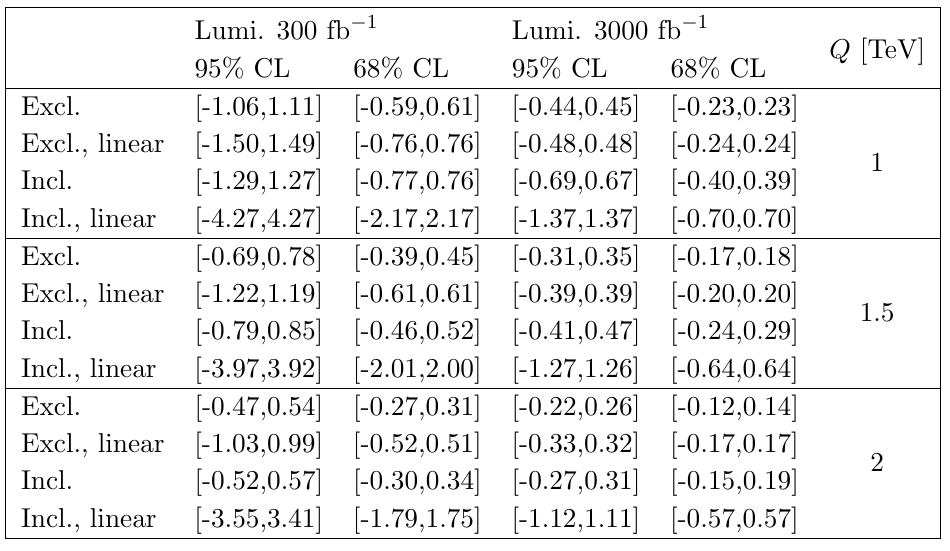
Table 1 . Exclusive (Excl.) bounds on c 3 W = (cid:3) 2 (cid:2) TeV 2 are obtain according to the method described 6 100 GeV. in section 5, binning in (cid:30) Z and p T . Inclusive (Incl.): no binning and jet veto at p T j j The bounds of the rows Excl./Incl., linear are obtained by including only the linear terms in c 3 W BSM cross section. The total leakage in the various bins of m T is . 5% for each value of Q WZ